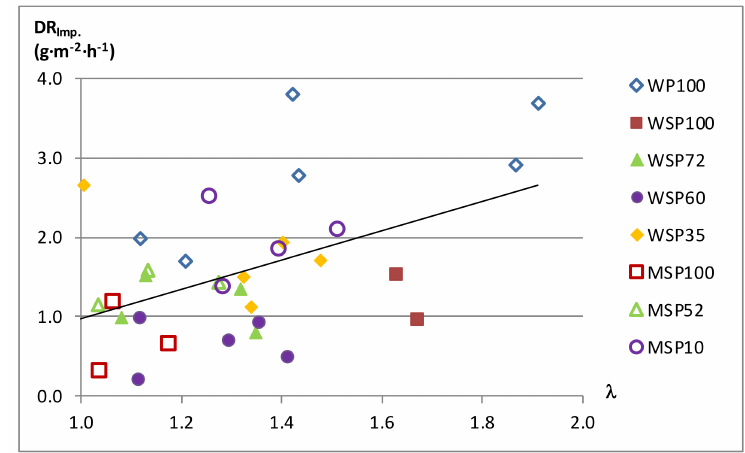
Figure 6. Deposition rates by inertial impact versus λ .